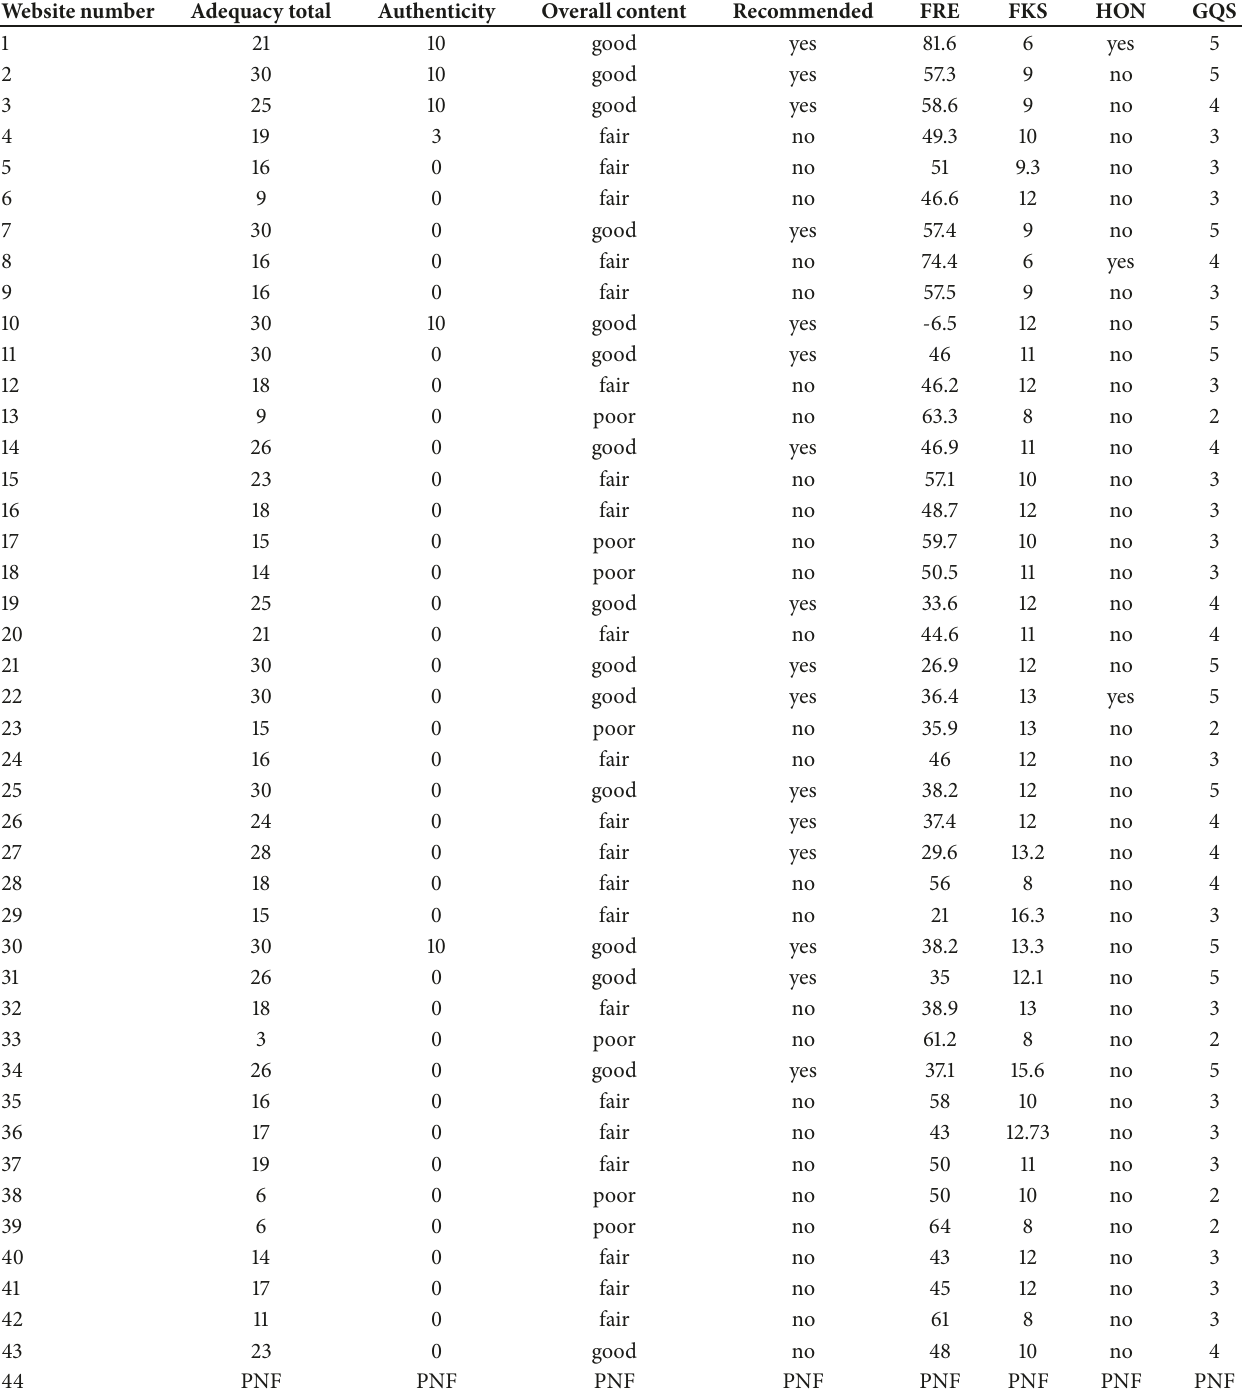
Table 3: Results of website content analysis and readability assessment.